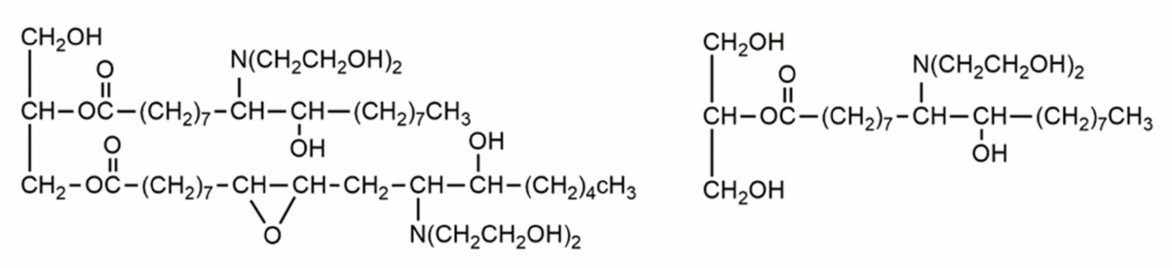
Figure 2. Selected products of partial aminolysis of glyceride groups (ester groups) and reaction of oxirane groups with diethanolamine.